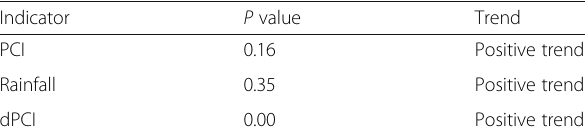
Table 3 The CM Trend for R, PCI and dPCI in the study area from 1951 till 2010